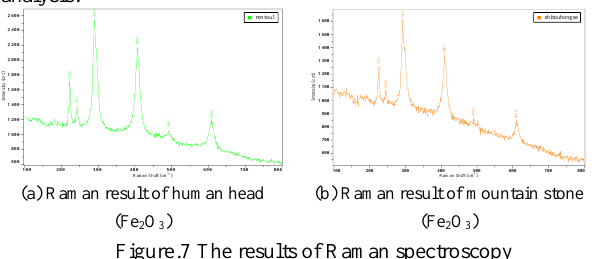
Figure.7 The results of Raman